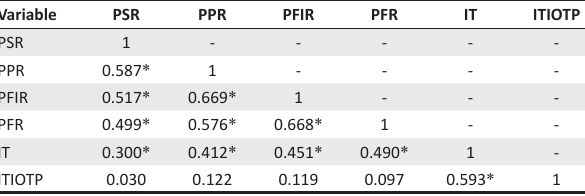
TABLE 3: Correlation